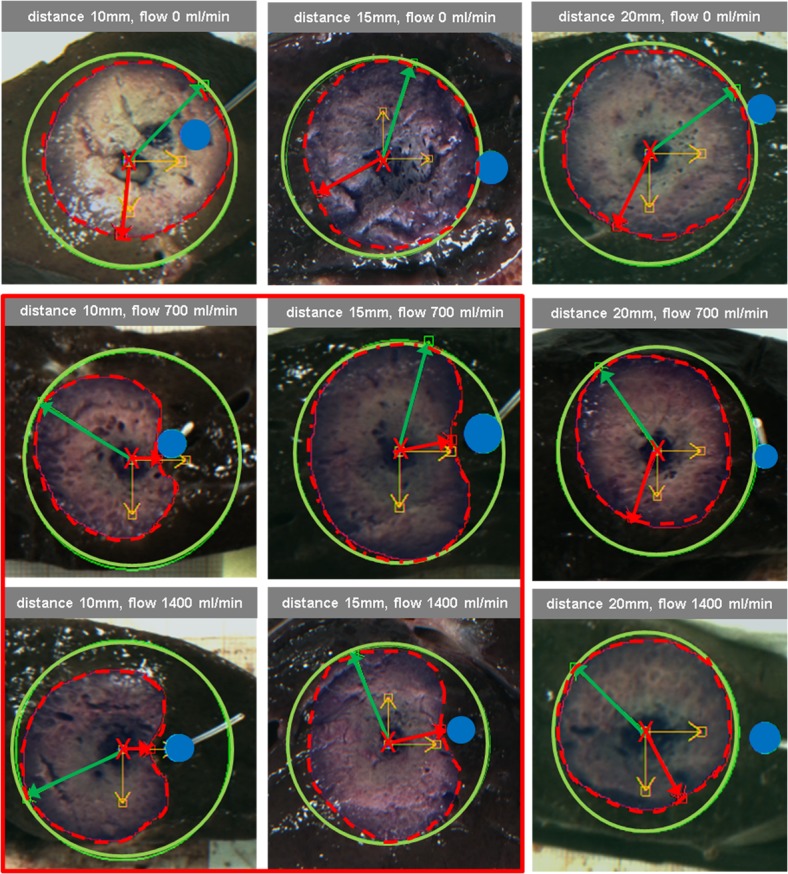
Demonstration of the heat sink effect in hepatic microwave ablation, depending on flow and distance to simulated hepatic vessels.Considerable changes in ablation zone morphology as reflected by minimum radius and lesion area can be observed in ablation procedures performed within 15mm of perfused vessels. Red cross = position of microwave antenna; blue circle = position of vessel; red arrow = minimal ablation zone radius; green arrow = maximum ablation zone radius; red dashed line = real ablation zone area; green line = idealized ablation zone area.